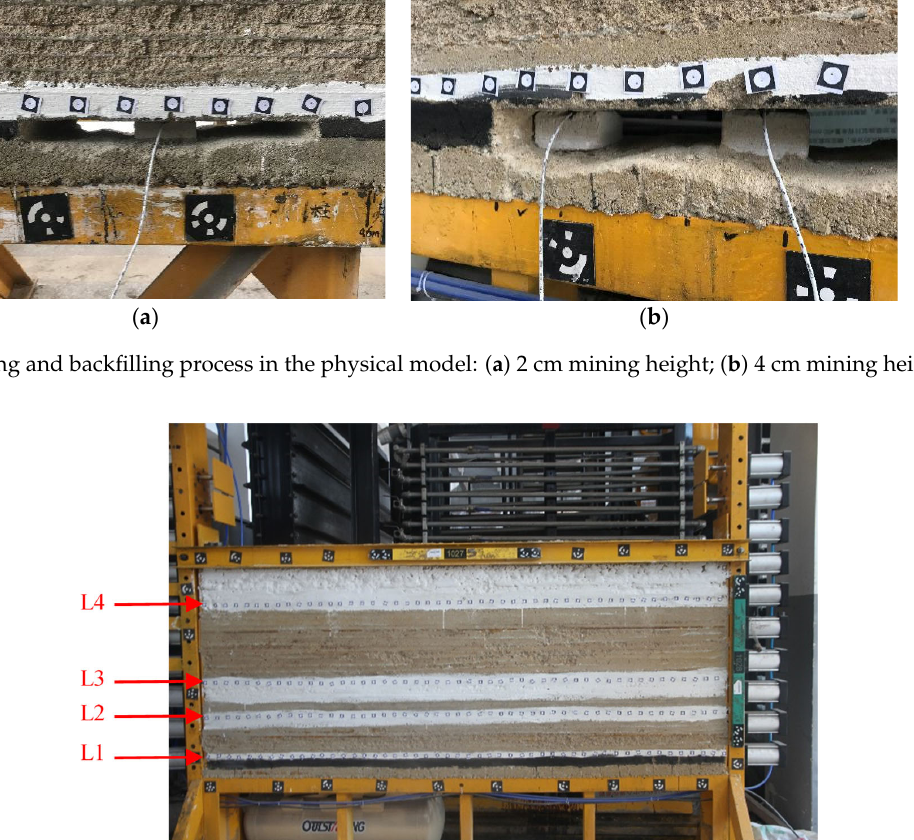
Figure 9. Measuring points layout for observation of strata movement.